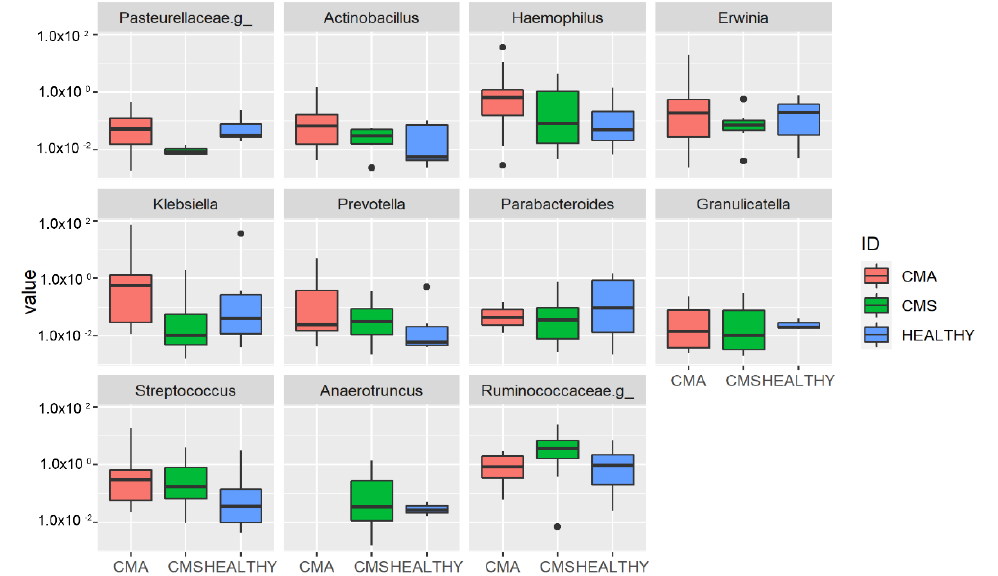
Figure 5. Operational Taxonomic Unit (OUT) distribution of the gut microbiota for the three groups’ comparison assessed by DeSeq2 test at genus level. The interquartile range is represented by the box and the line in the box is the median. The whiskers indicate the largest and the lowest data points, respectively, while the dots symbolize outliers. Only statistically significant OTUs ( p < 0.05) are plotted.